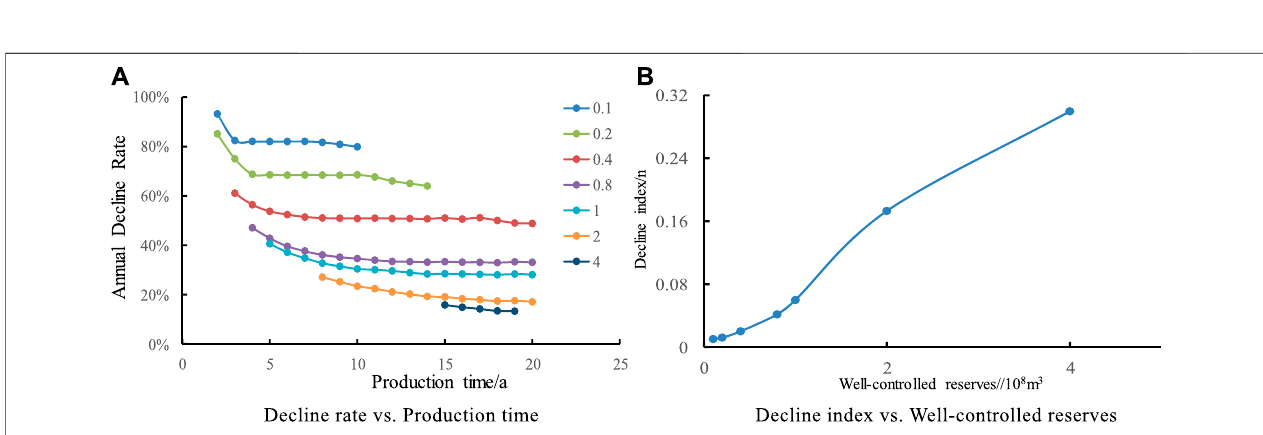
FIGURE 6 | Effect of well-controlled reserves on Annual Decline Rate and decline index. (A) Decline rate vs. Production time. (B) Decline index vs. Well-controlled reserves.